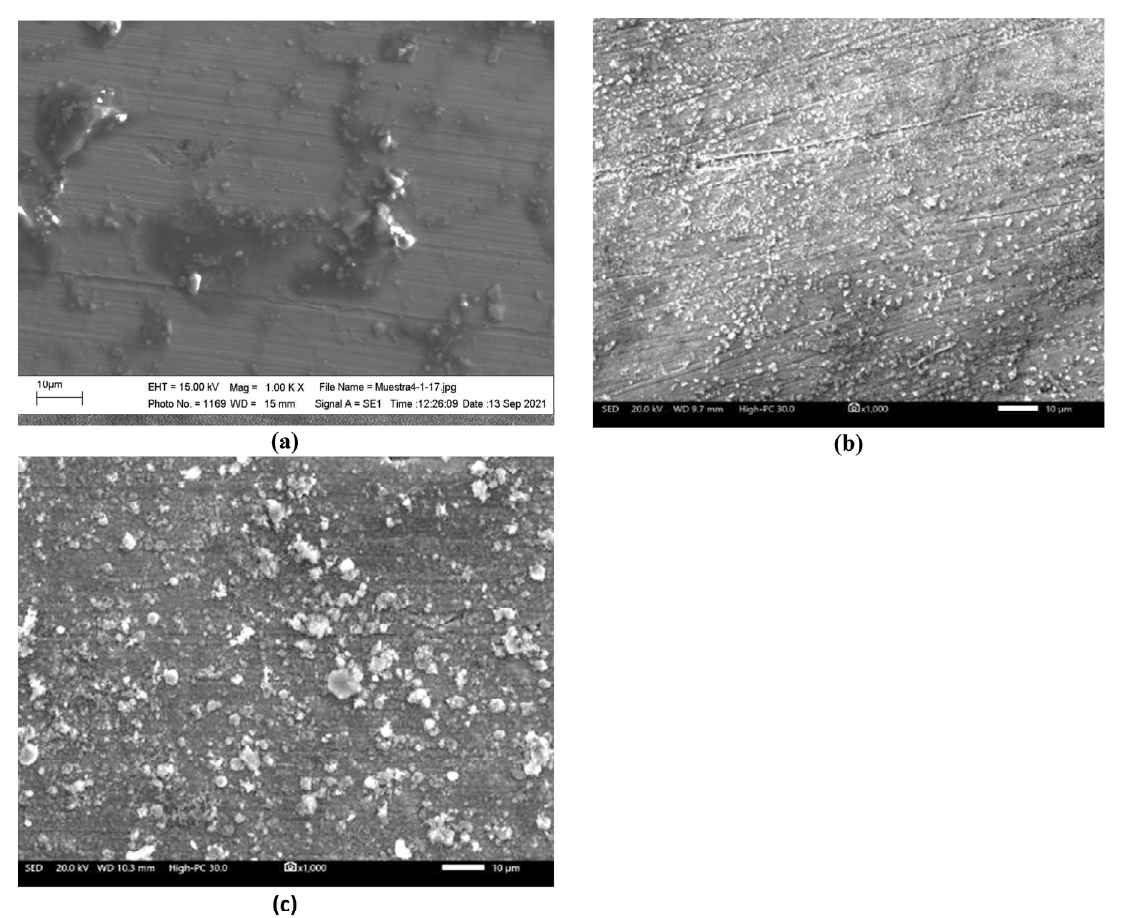
Figure 2. Morphological aspects of the Ni20Cr alloy surface immersed in Solar Salt after 1000 h of immersion and at different test temperatures: ( a ) 300 °C, ( b ) 400 °C, and ( c ) 500 °C.